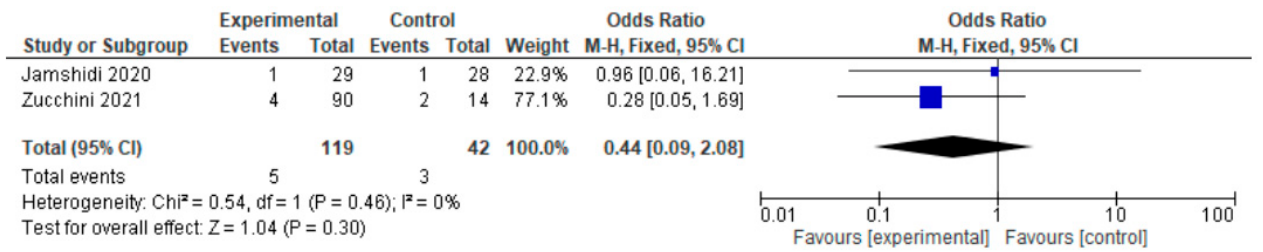
Figure 4. Forest plot of local recurrence comparing in proximal femur tumor patients undergoing HA and THA [21,22].